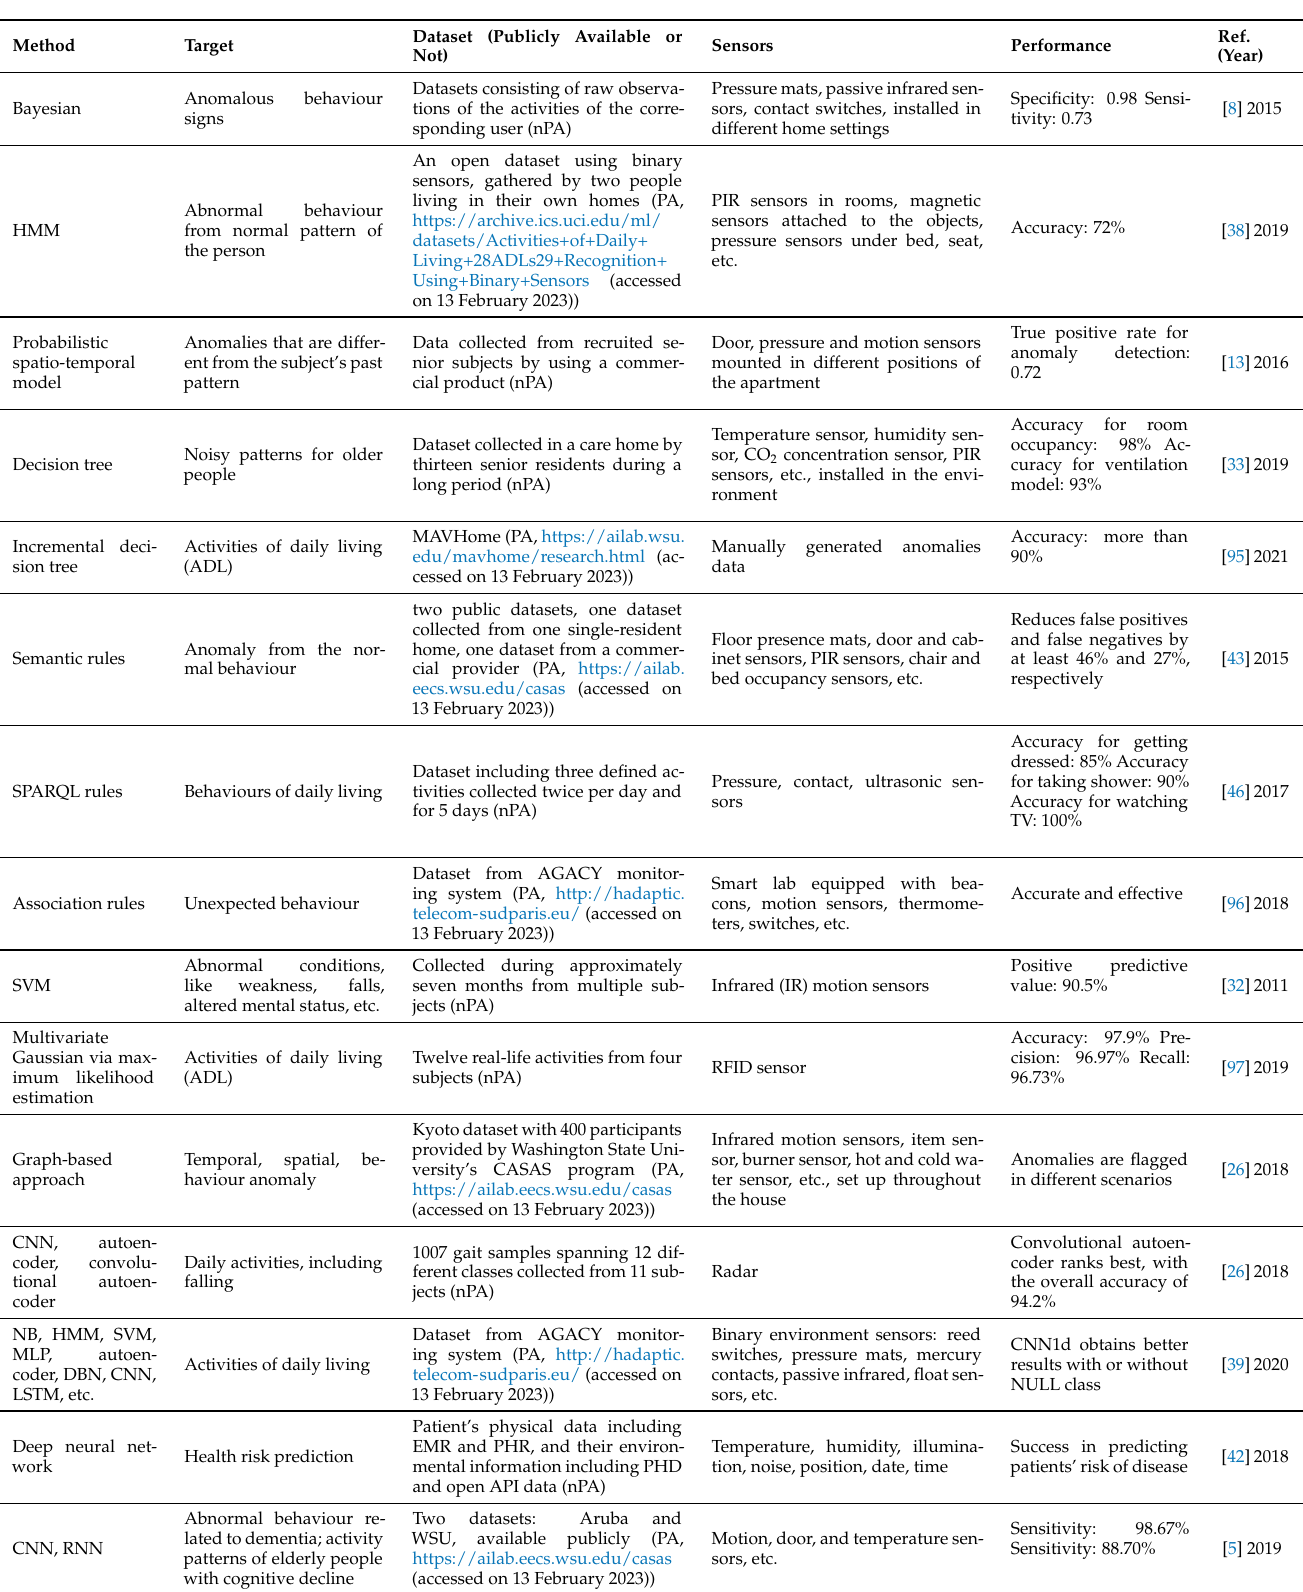
Table 7. Typical studies in pervasive sensor-based abnormal activity